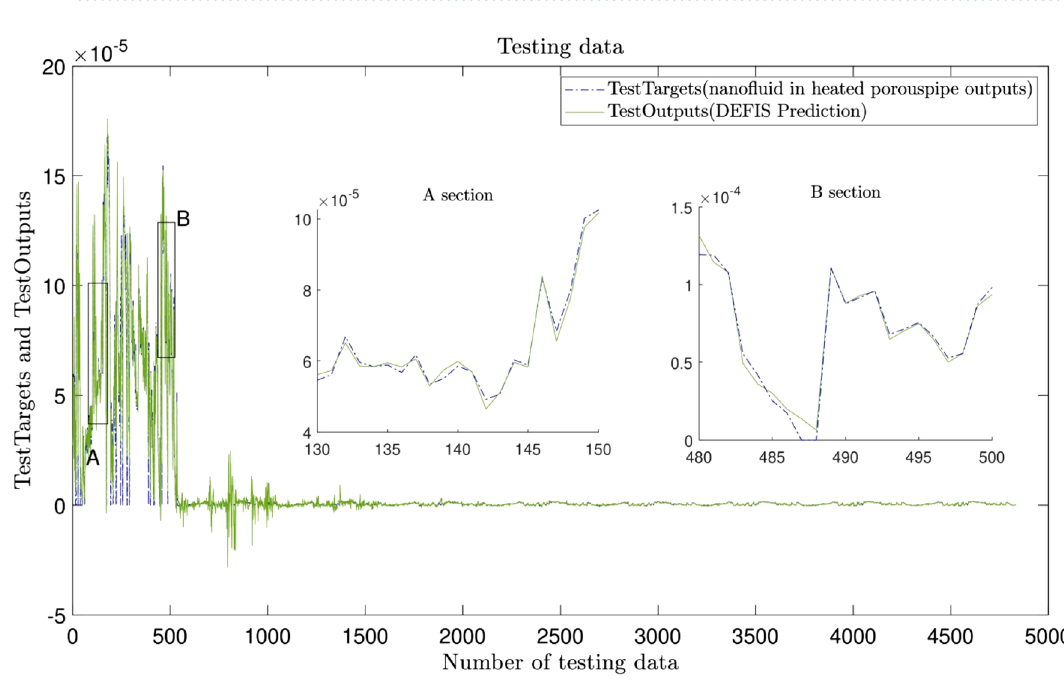
Figure 7. Validation of learning